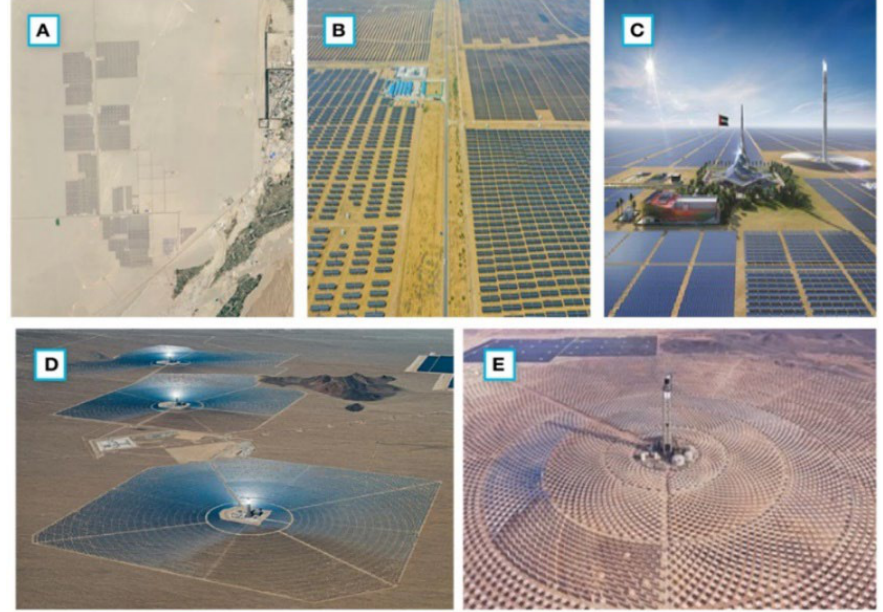
Figure 5. Solar power plants in the desert. ( A ) China; ( B ) the Kubuqi Desert in China; ( C ) the Mohammed bin Rashid Al Maktoum Solar Park in Dubai; ( D ) the Cerro Dominador solar thermal plant in Chile; ( E ) the Mojave Desert.